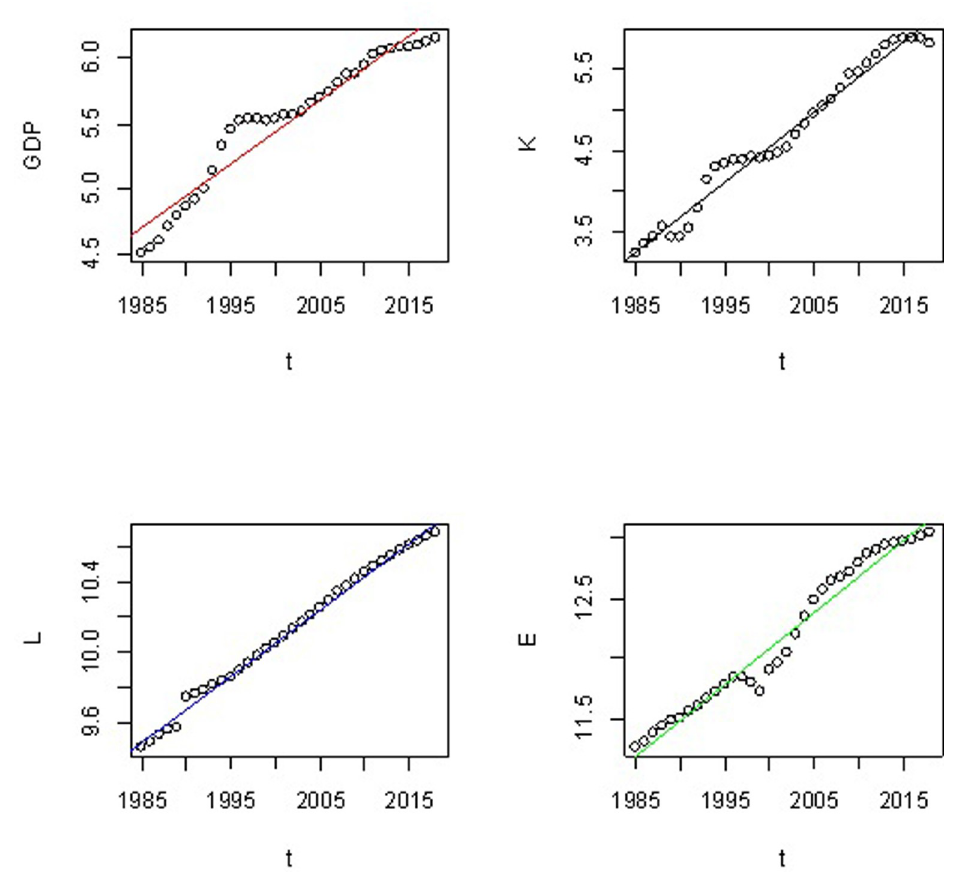
Fig 6. Logarithmic sequence trend chart of GDP, capital (K), labor (L), and energy (E).